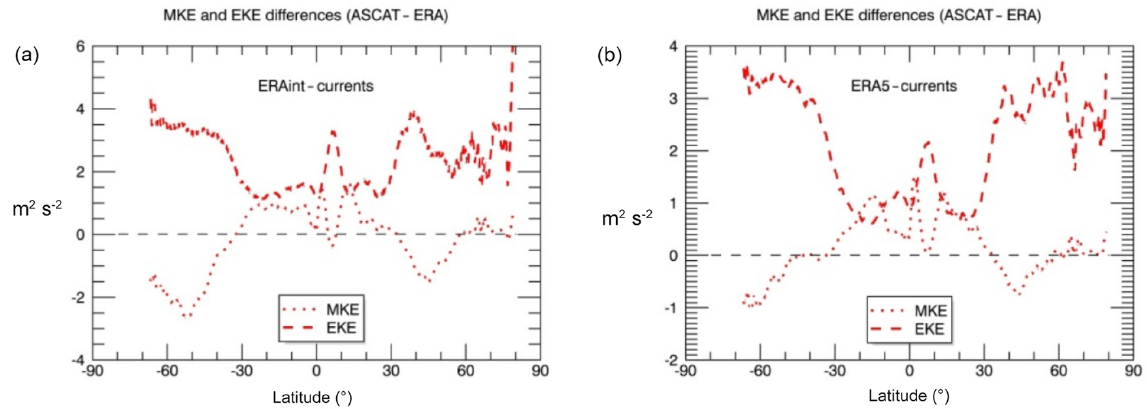
Figure 13. Zonally averaged differences in mean kinetic energy (MKE; dots) and eddy kinetic energy (EKE; dashes) between ASCAT observations and ERA-Interim (a) and ERA5 (b) first-guess winds over 2016 after the ocean current